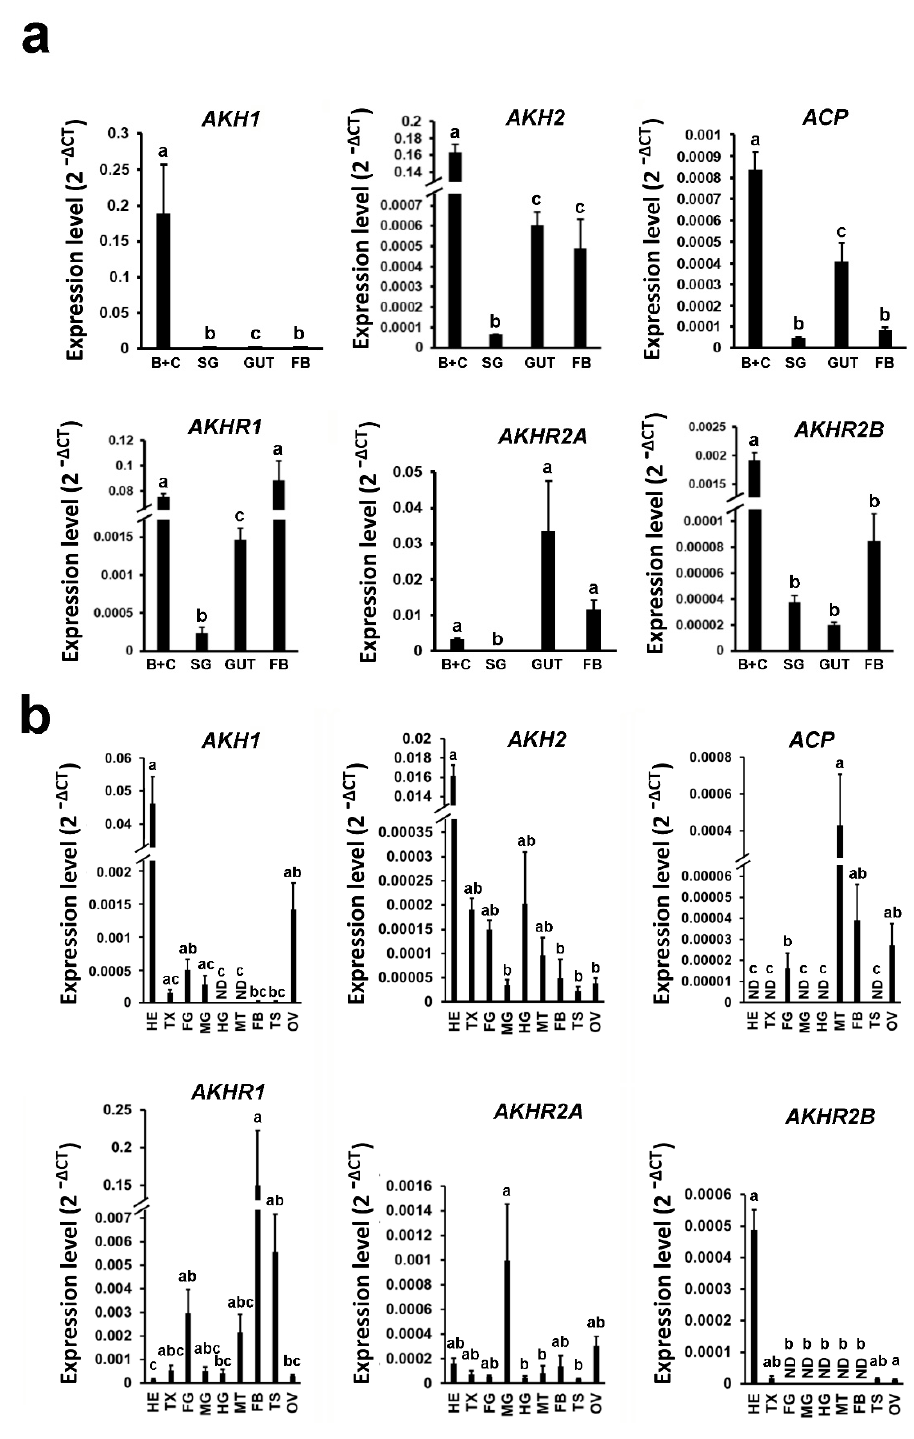
Figure 1. AKH and AKHR isoforms differ in the tissue specificity of their expression. RT-PCR analysis of AKH and AKHR mRNAs was performed using tissues from larvae ( a ) as well as adult moths ( b ). The adult RNA samples other than testes and ovary contained male and female tissues in equal proportions. The mRNA levels were measured relative to BmActin, and BmTubulin mRNAs. The samples contained pooled tissues from several individuals. Values represent means ± SD from three independent experiments. Data were analyzed by Kruskal–Wallis test followed by pairwise comparisons using Wilcoxon rank sum test. The significant differences are indicated by different letters ( p < 0.5). HE—head; TX—thorax; FG—foregut; MG—midgut; HG—hind gut; MT—Malpighian tubules; FB—fat body; TS—testes; OV—ovary; B+C—brain with corpora cardiaca; ND—not detected.